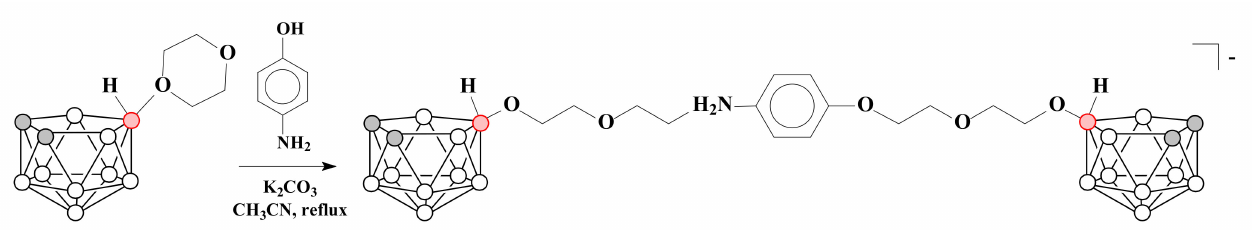
Scheme 17. The reaction of 1,4-dioxane derivative of nido -carborane with 4-aminophenol in the presence of K 2 CO 3 .